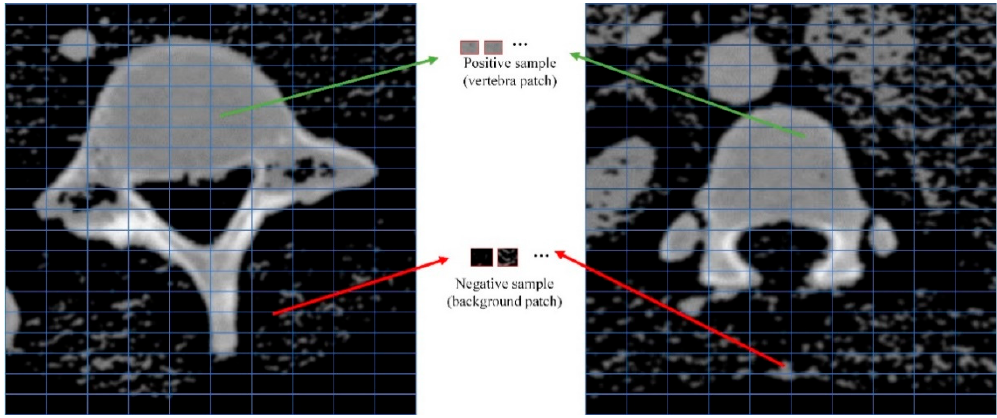
Figure 4. Positive and negative samples of the CT image.